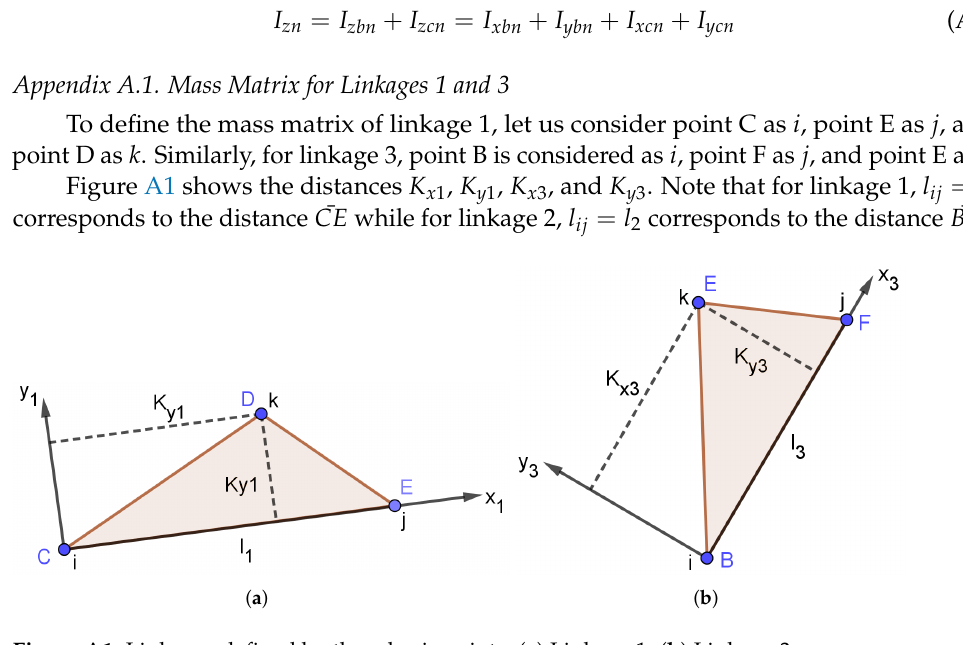
Figure A1. Linkages defined by three basic points. ( a ) Linkage 1. ( b ) Linkage 3. By using the mass matrix M 3P (Equation (24)), the terms of the mass matrix for linkages n = 1 and n = 3 can be defined according to Equations